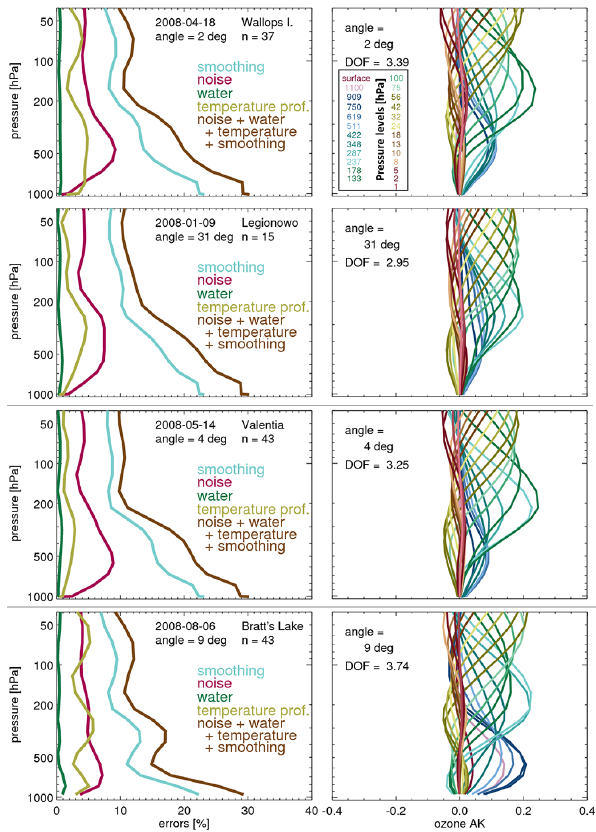
Figure 1. Averaging kernels and errors for selected locations. The angle in the individual panels refers to the viewing angle of the IASI instrument and DOF to the degrees of freedom for signal.